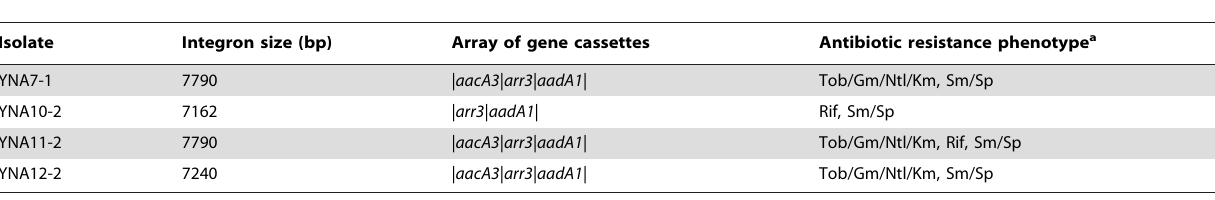
Table 3. Characteristics of resistance integrons in four resistant isolates of X. oryzae pv. oryzae .